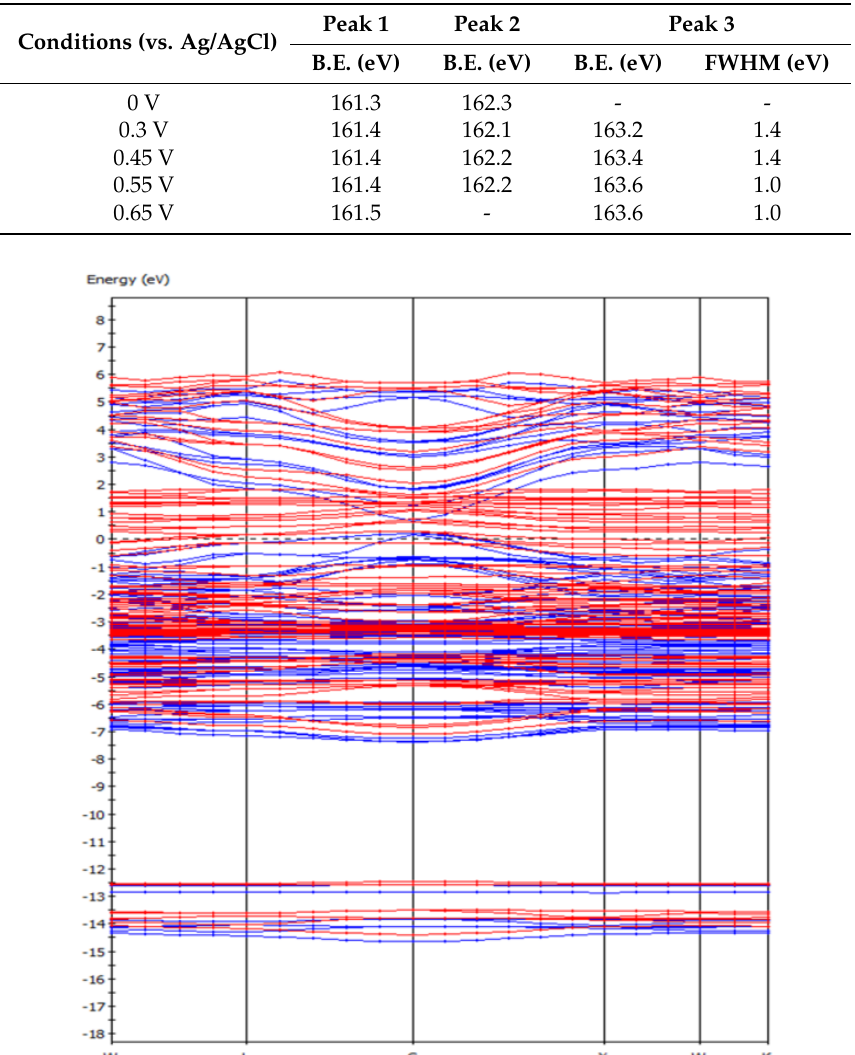
Figure 2. The band structure of bornite (X-axis, High symmetry point; Y-axis, Energy/eV) in DFT calculation (CASTEP module of Materials Studio 6.0 software package, PBE density function, Hubbard + U correction).